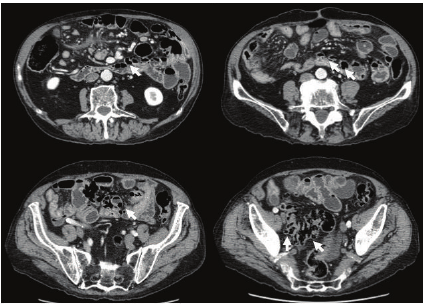
Figure 2: Computed tomography showing presence of gas in the intestinal wall (harrows).